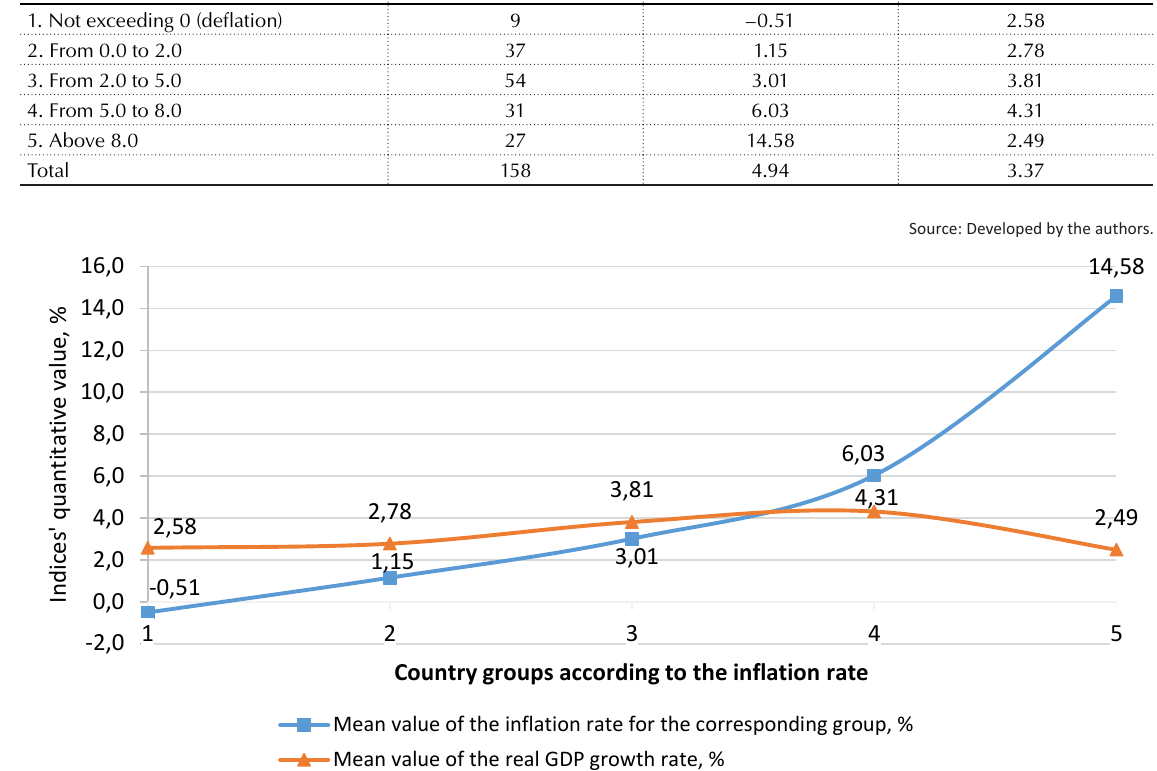
Figure 1. Graphic presentation of real GDP growth rate dependence on